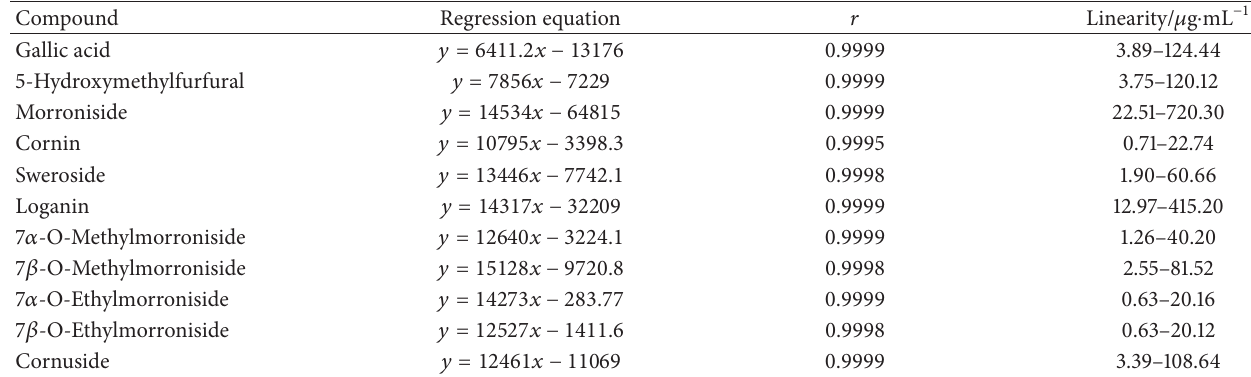
Table 2: Standard curves of 11 components in Fructus Corni . Compound Regression